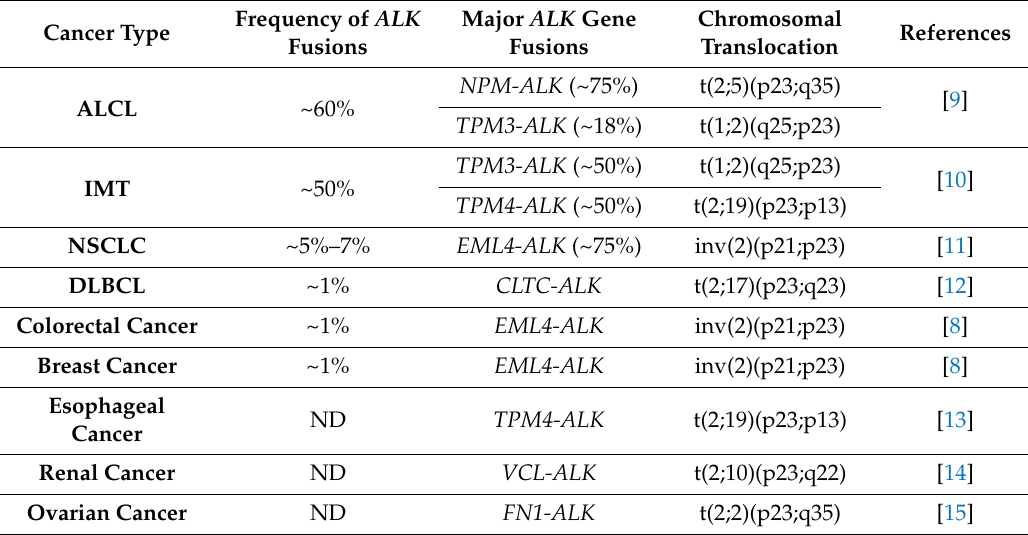
Table 1. Common anaplastic lymphoma kinase ( ALK ) gene fusions found in various